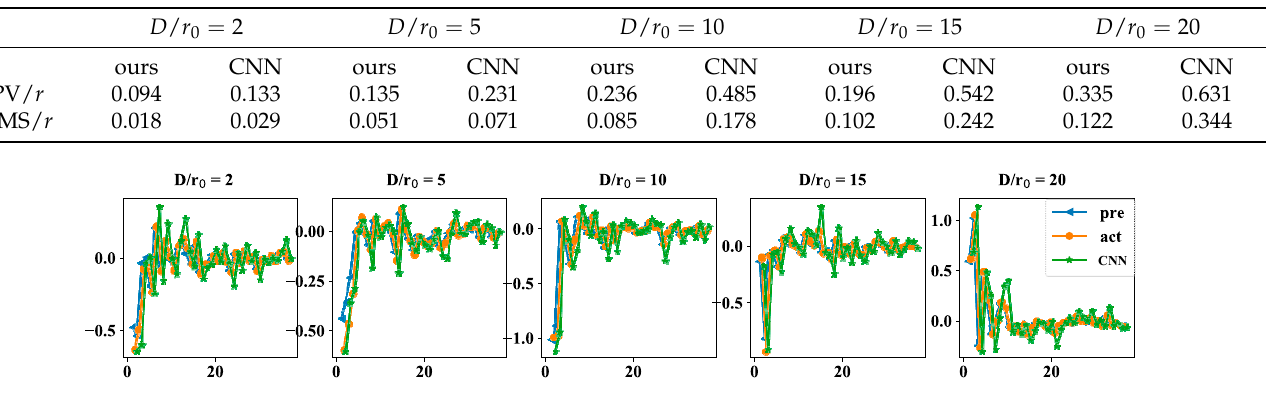
0.344 After reconstructing the wavefront based on the predicted Zernike coefficients, the correction of the turbulent phase can be achieved by loading an inverse phase wavefront to the distorted beam. To verify the effectiveness of the inverse phase of the residual attention network in the OAM multiplexed communication system, the topological charge of the fixed transmission beam is 1, − 2, 3, and − 5, the signal-to-noise ratio is set to 10, the modulation is quadratic phase-shift keying, and other conditions remain unchanged, and the experimental simulation is carried out under different turbulence intensities, the results of which are shown in Figure 8. It can be seen that the system BER increases as the turbulence intensity becomes stronger. Compared with the CNN network model, the system with the lowest BER after correction using the model in this paper, the system performance is not improved much after using the Gerchberg–Saxton phase recovery algorithm. The system without the phase correction algorithm has the highest BER, which is indicated by none in the figure, and it can be seen that the BER of the uncorrected signal hardly exceeds the Forward Error Correction (FEC) limit.